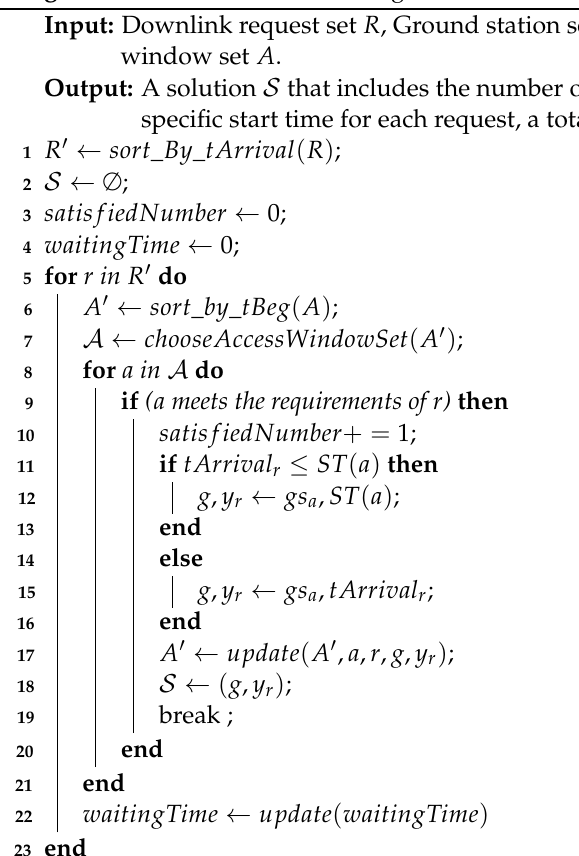
Algorithm 1: Downlink scheduling based on arrival